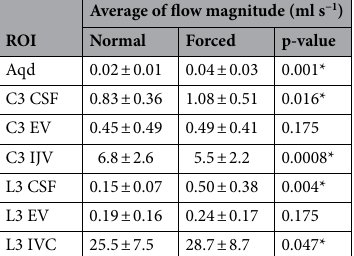
Average of flow magnitude (ml s −1 ROI